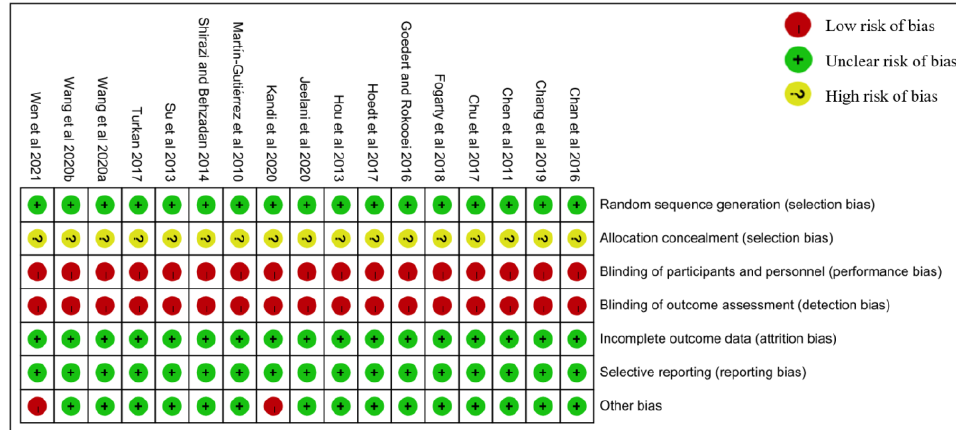
Figure 11. Risk of bias graph.